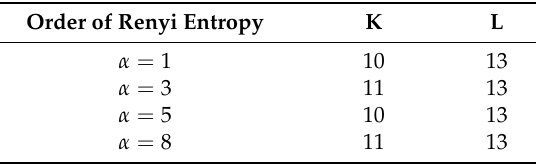
Table 3. Parameters of HMM-R at attack ratio of